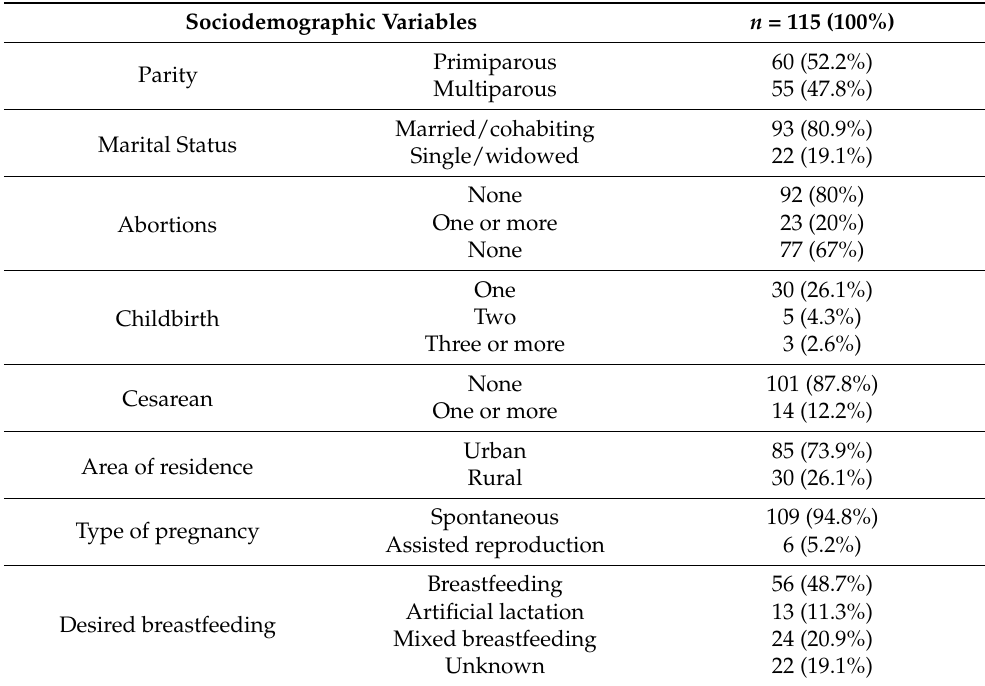
Table 1. Descriptive statistics of the